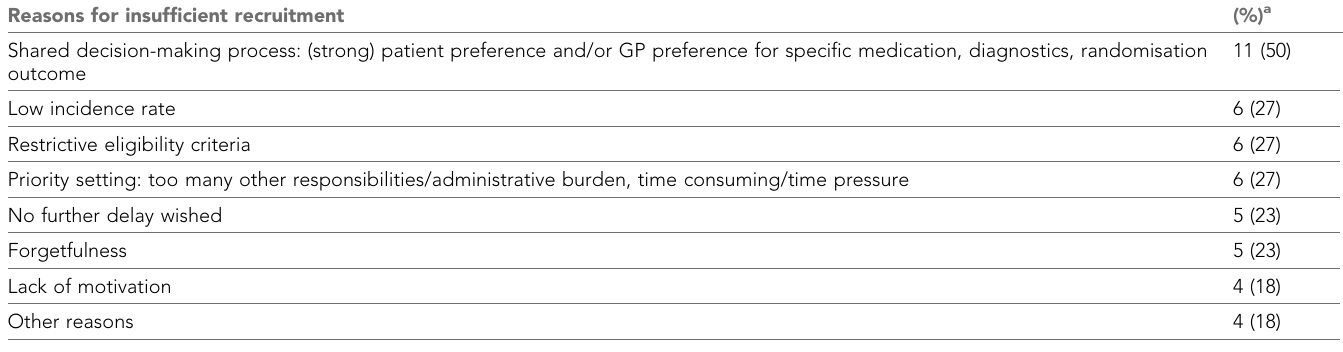
Table 1. Summary of responses of 22/116 (19%) GPs Reasons for insufficient